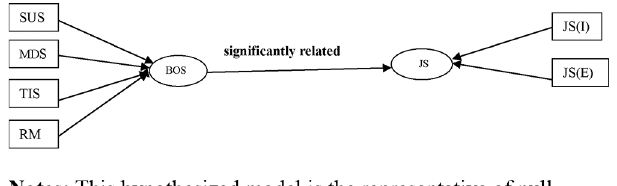
Figure 1. Hypothesized model of relationship between BoS and job